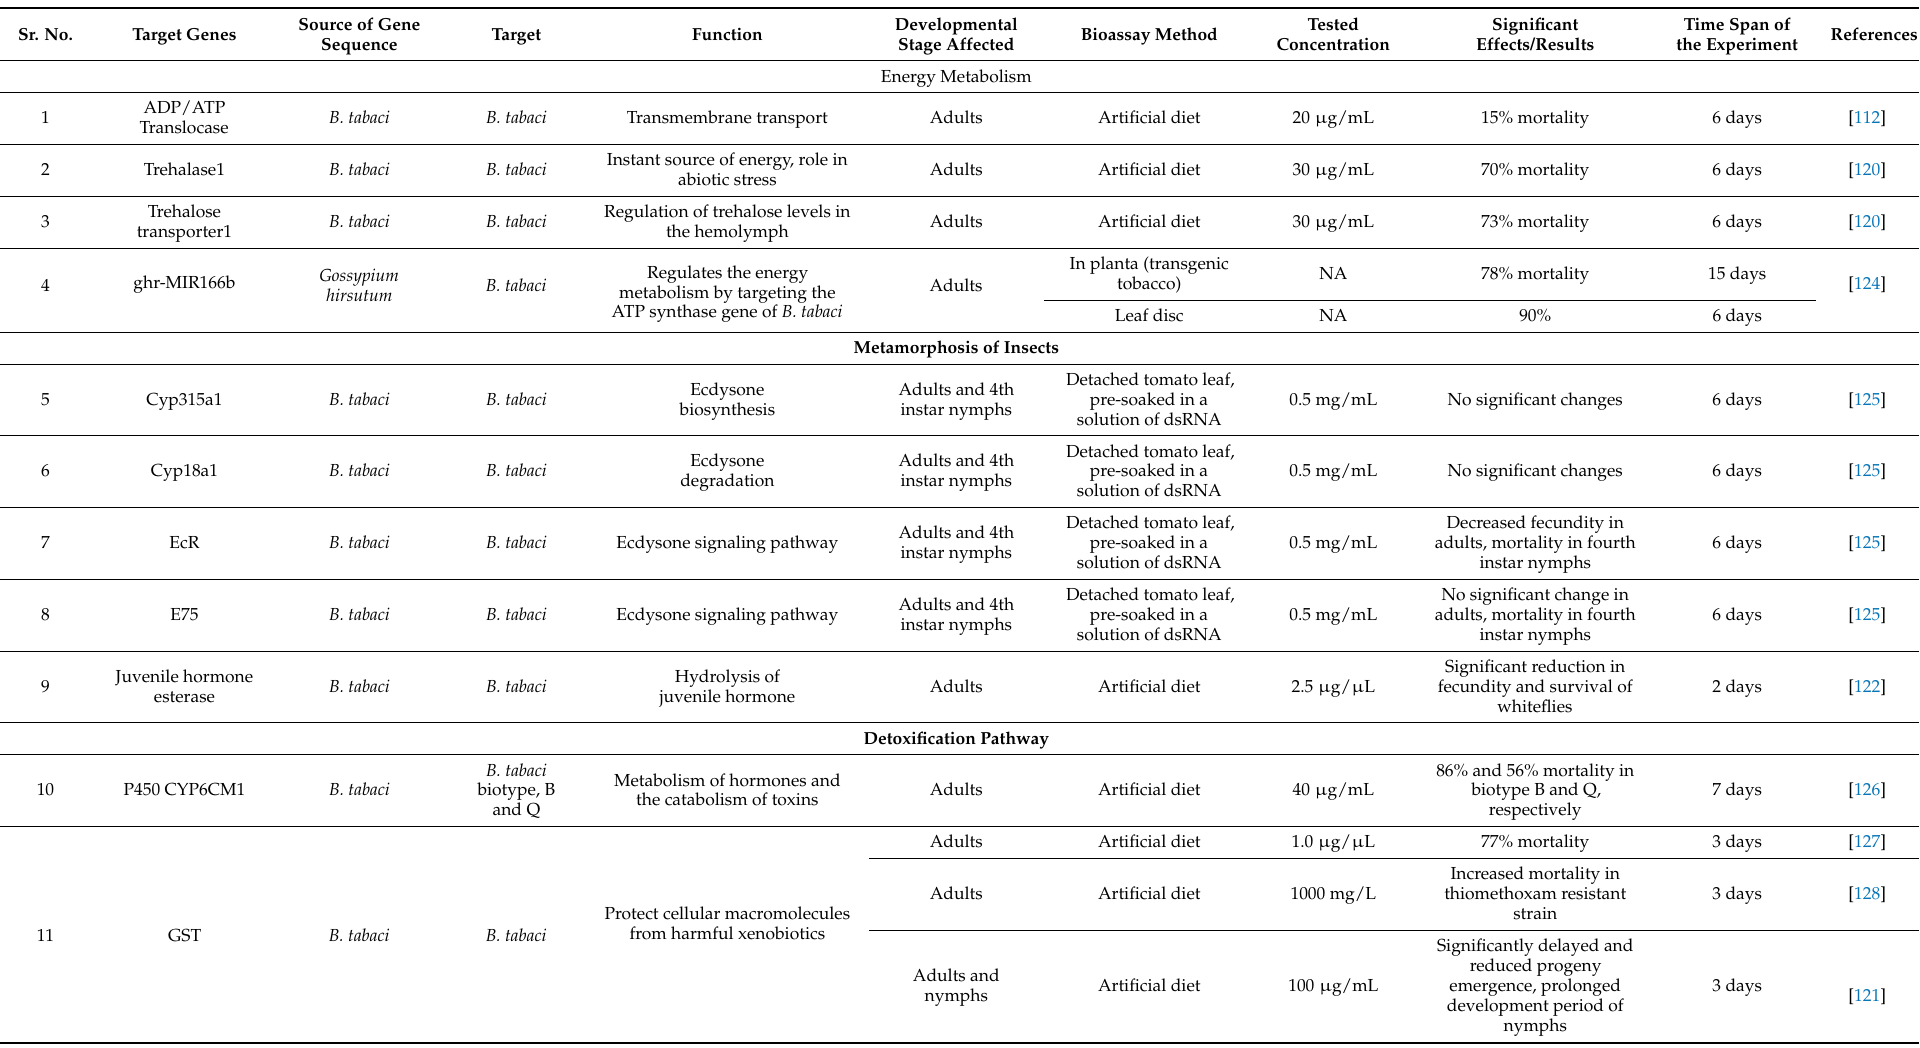
Table 4. The implication of RNA interference for the control of sweetpotato whitefly and associated viral